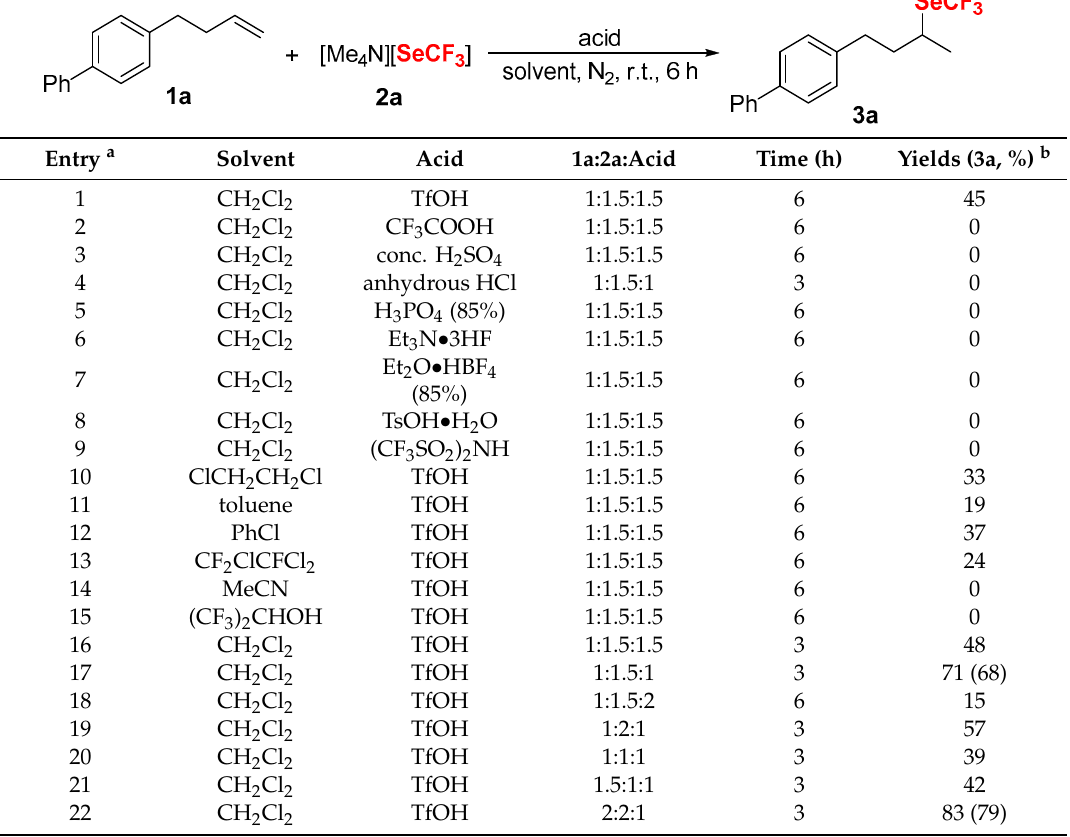
Table 1. Hydrotrifluoromethylselenolation of 1a with [Me 4 N][SeCF 3 ] and an acid.